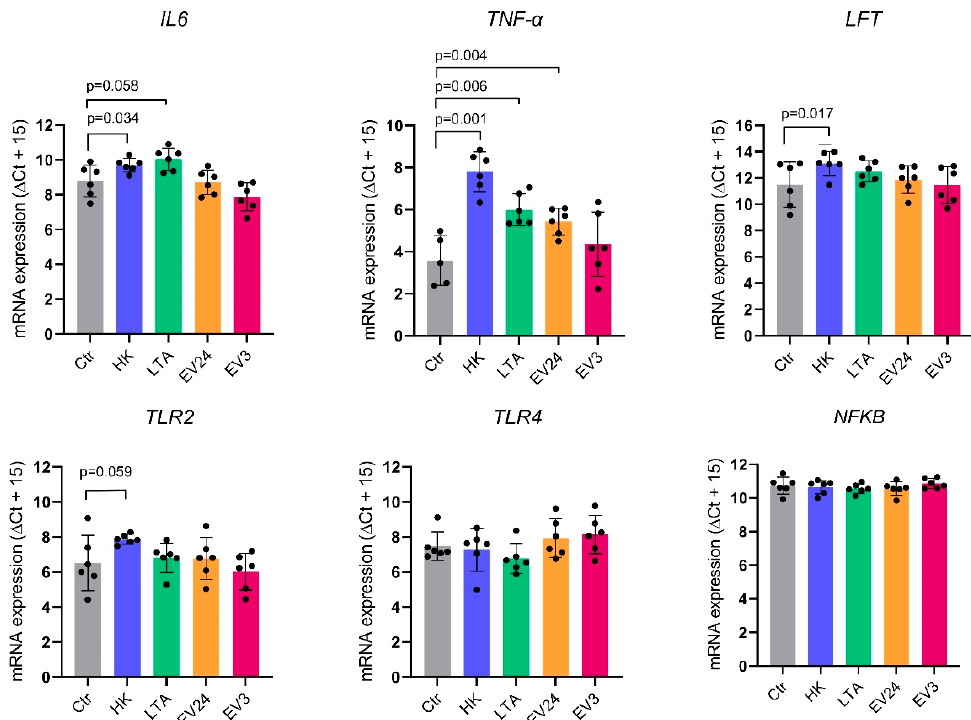
Figure 3. Differential expression analysis for interleukin 6 ( IL-6 ), tumour necrosis factor-alpha ( TNF- α ), lactoferrin ( LTF ), toll-like receptor 2 ( TLR2 ), toll-like receptor 4 ( TLR4 ) and nuclear factor-kappa B ( NF κ B ) of primary bovine mammary epithelial cells (pbMECs) after stimulation with PBS (Ctr), heat-killed S. aureus M5512VL (HK), lipoteichoic acid (LTA) for 24 h, or S. aureus M5512VL EVs for 24 (EV24) and 3 h (EV3) stimulation, respectively. Relative abundance values are expressed in ∆ Cq, showing the mean value + SD from six biological